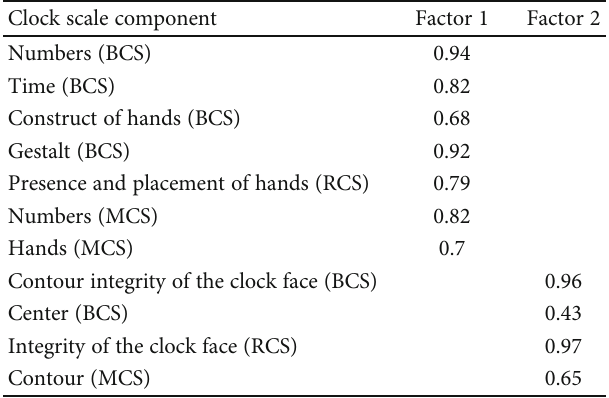
Table 3: Factor analysis of subcomponents of all the three